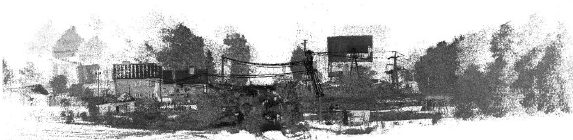
Table 4. The results of TLS data orientatio